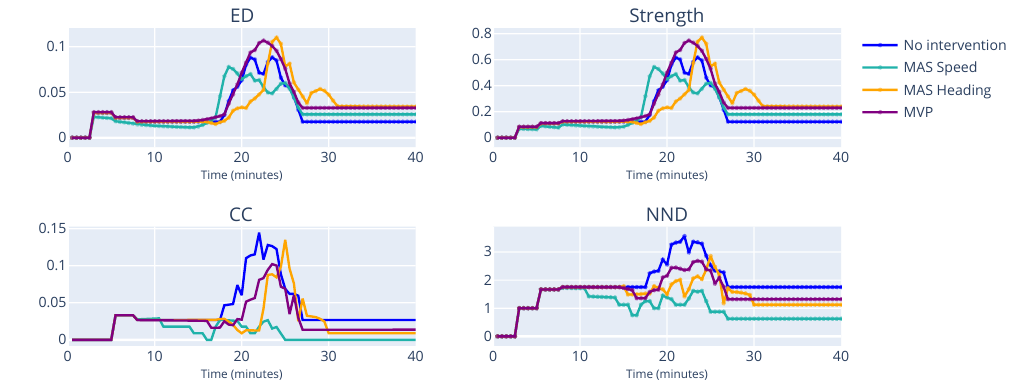
Figure 13. Miles-in-Trail with 8 aircraft per flow.